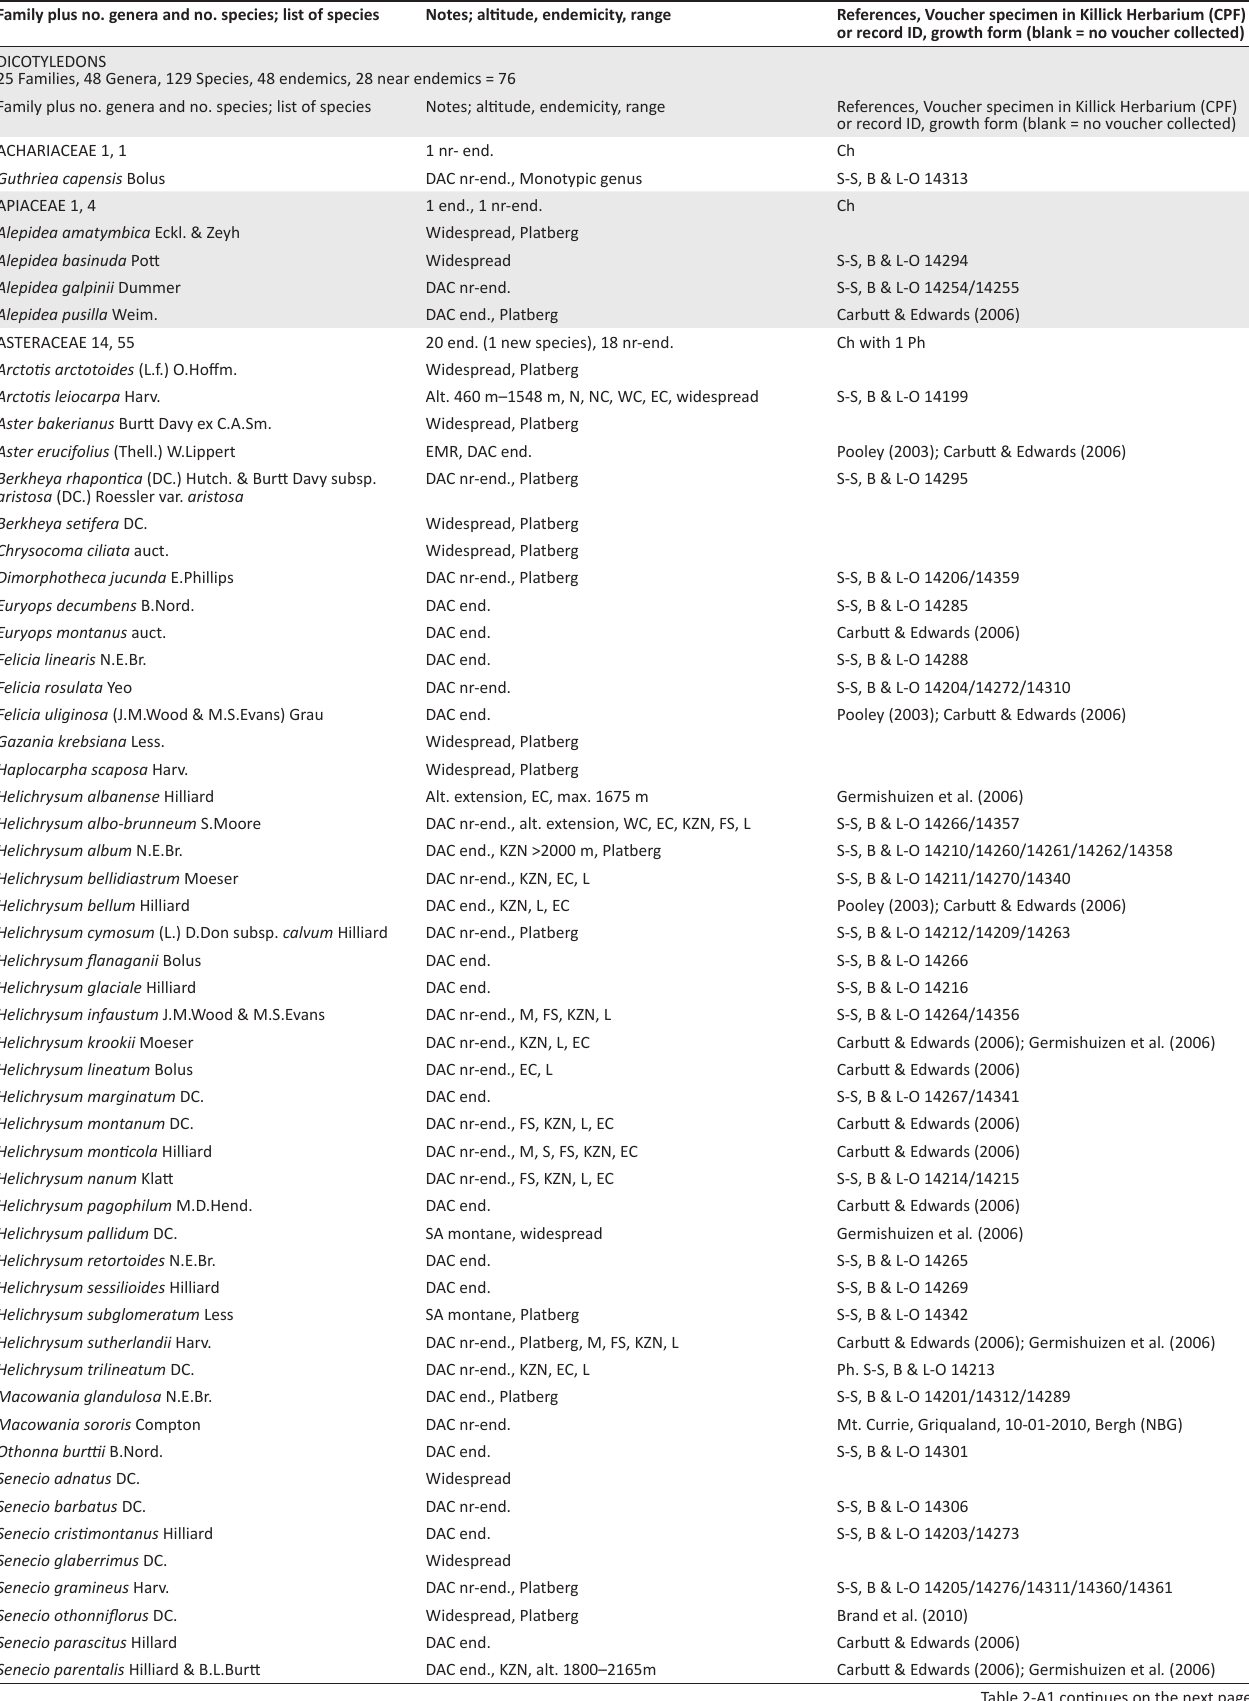
TABLE 2-A1: Angiosperms – Monocotyledons, 16 Families, 37 Genera, 66 Species, 13 endemics, 25 near endemics = 38. Family plus no. genera and no. species; list of species Notes; altitude, endemicity,